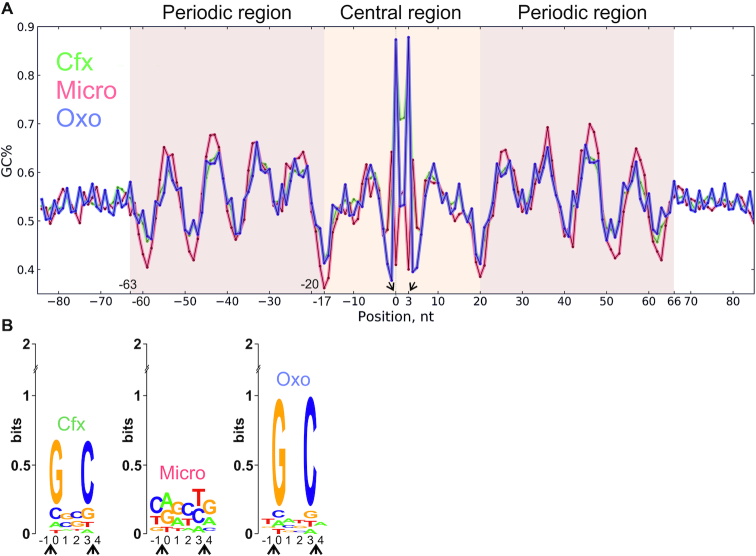
DNA gyrase has a binding motif revealed with a range of poisons: Cfx, Micro, and Oxo. (A) DNA sequences under GCSs were extracted and aligned; resulting motif, shown as a plot of GC content, has a central region (–16:19 nt) around the cleavage site, and two periodic regions (–63:–17 and 20:66 nt). (B) Logo representation of motif's central part around cleavage site. In the coordinates chosen, DNA gyrase cleaves forward chain between -1 and 0 and reverse chain between 3 and 4 bp (cleavage events are indicated with arrows).